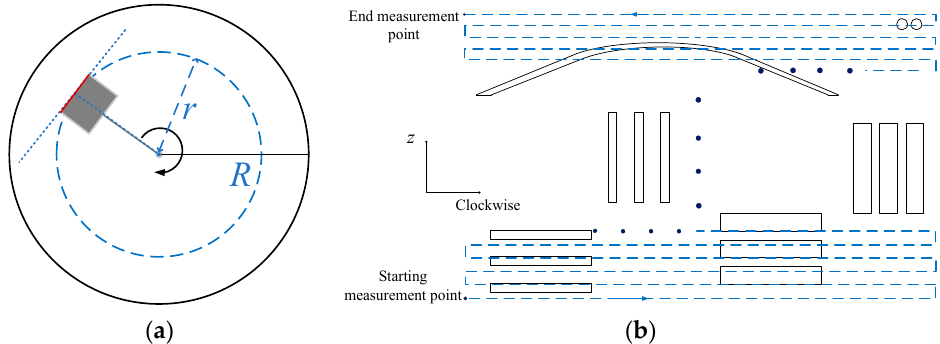
Figure 10. Schematic of the measurement method of the simulated borehole. ( a ) Schematic of the position of the transducer in the experimental measurement and ( b ) Schematic of the moving track of the ultrasonic transducer, unfolded drawing along the inner wall of the borehole.